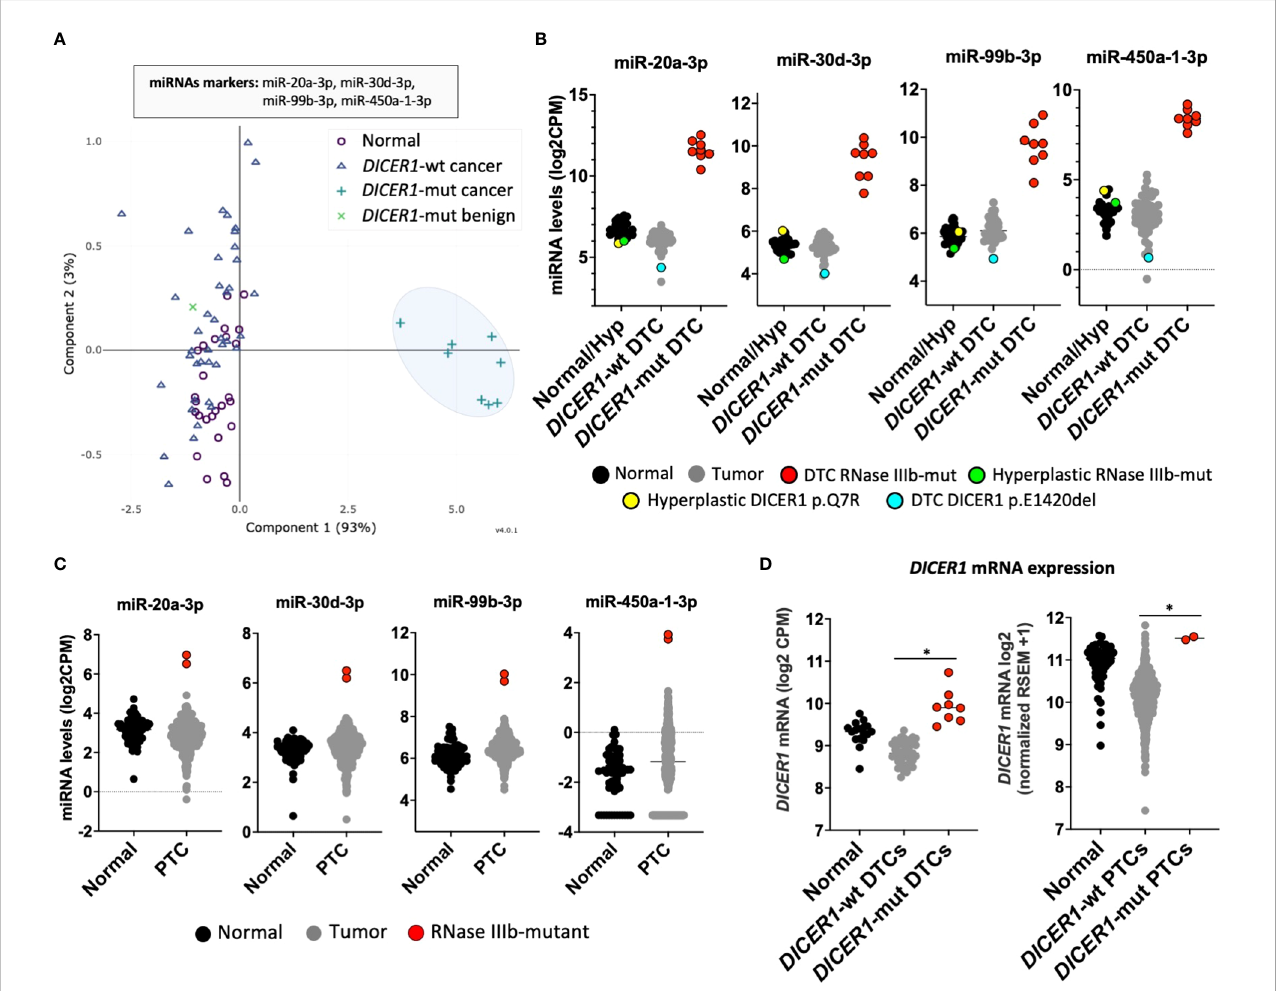
FIGURE 2 DICER1 -mutant thyroid cancers exhibit unique miRNA signature. (A) Principal component analysis (PCA) of miRNA expression pro fi les from differentiated thyroid cancer (DTC) and non-neoplastic/hyperplastic shows that a set of four miRNAs (mir-20a-3p, mir-30d-3p, mir-99b-3p, and miR-450a-1-3p) can identify DTC with RNase IIIb mutation. (B) Expression of 3p miRNA markers: mir-20a-3p, mir-30d-3p, mir-99b-3p, and miR-450a-1-3p in 28 non- neoplastic/hyperplastic thyroids, 52 DICER1 -wt DTC and 8 DICER1 -mutant DTC. (C) Expression of miRNA markers: mir-20a-3p, mir-30d-3p, mir-99b- 3p, and miR-450a-1-3p across 59 non-neoplastic thyroids and 506 papillary thyroid cancers (PTC) from the Thyroid Cancer The Cancer Genome Atlas (TCGA). Only the 2 PTC cases in the TCGA with DICER1 RNase IIIb domain mutations show overexpression of the 3p miRNA markers. (D) Expression of DICER1 mRNA in non-neoplastic/hyperplastic thyroid, DICER1 -wt tumors and DICER1 -mut tumors from our cohort (left) and Thyroid Cancer TCGA cohort (right). Asterisk represent p <